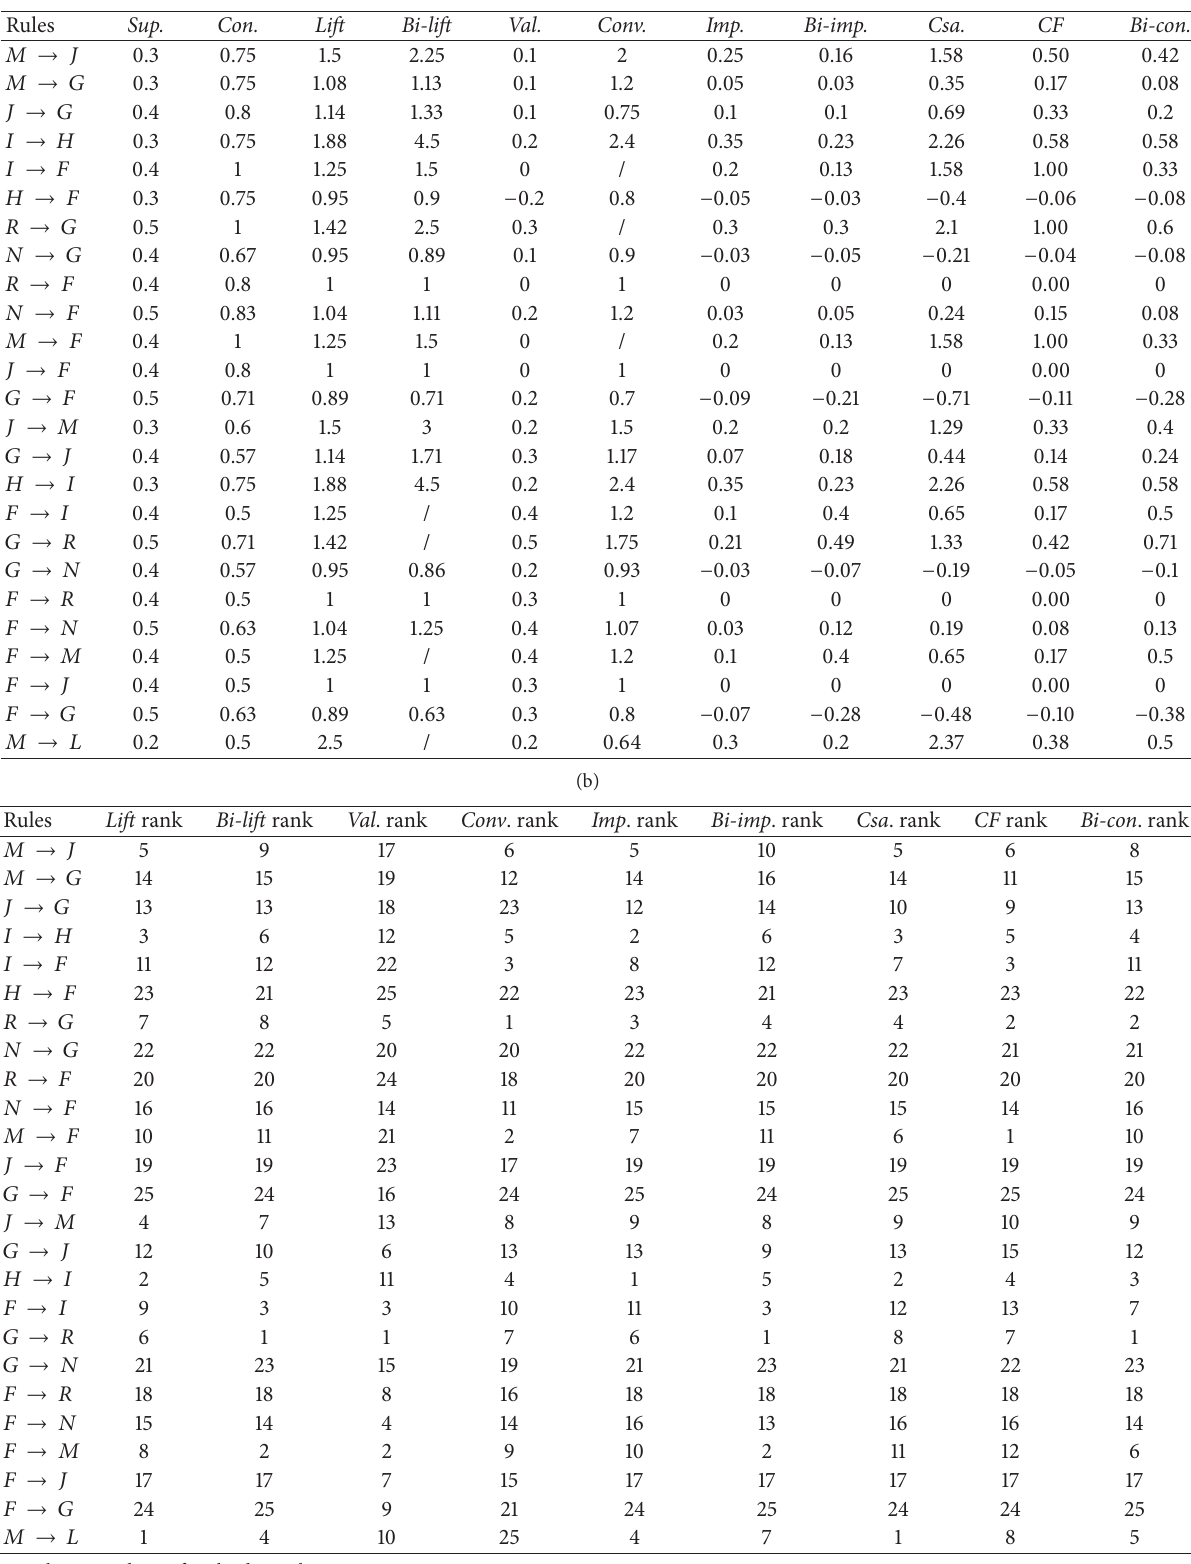
Table 5: Various measure evaluation results of various